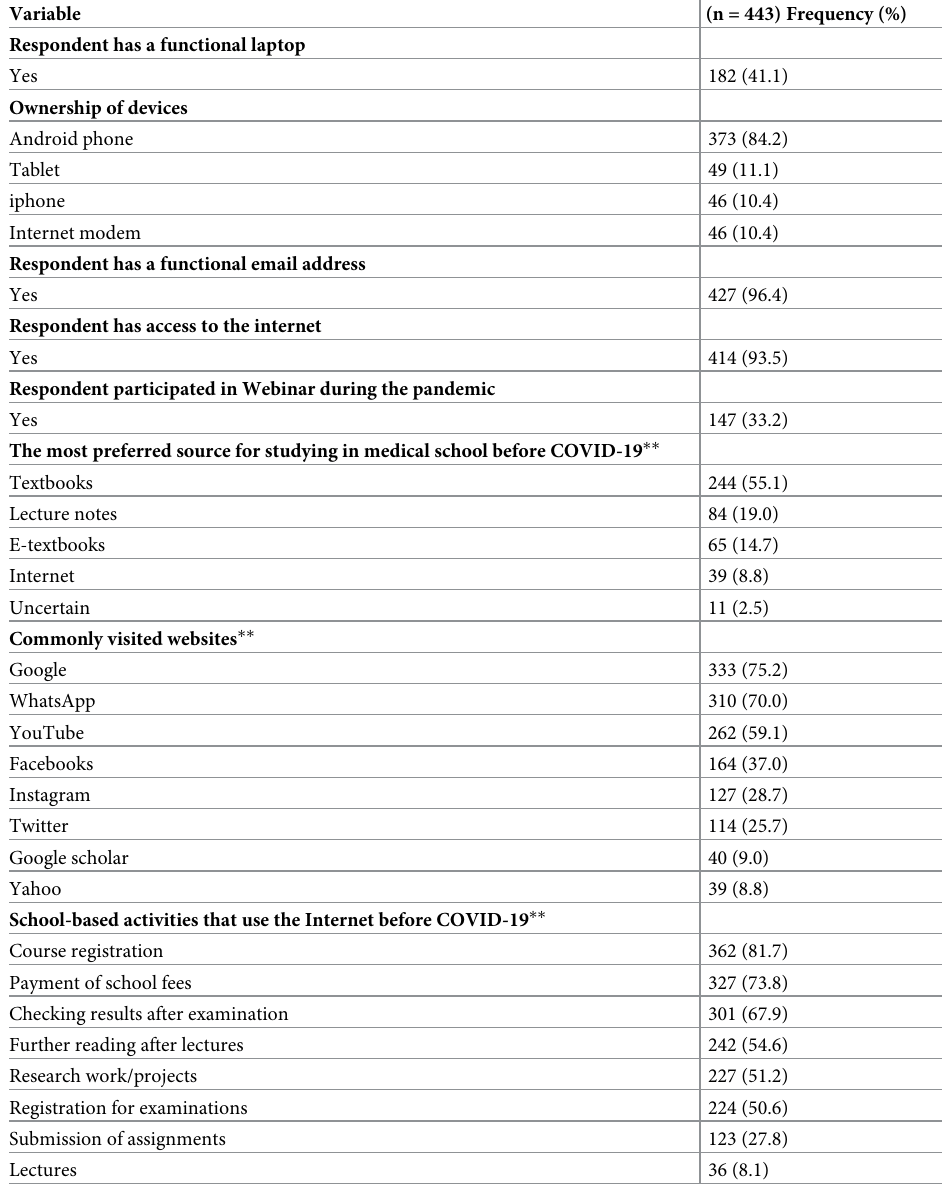
Table 2. Access to and application of internet services among the respondents. Variable (n = 443) Frequency